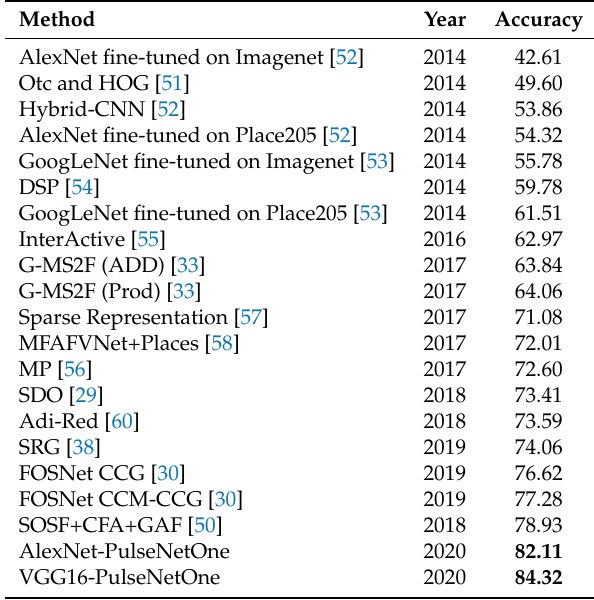
Table 12. Overall accuracies and standard deviations (%) of different CNNs methods along with PulseNetOne on the UC Merced dataset. The entries in bold show the method with the best classification for the network, while the percentage of the original network retained is highlighted in red.